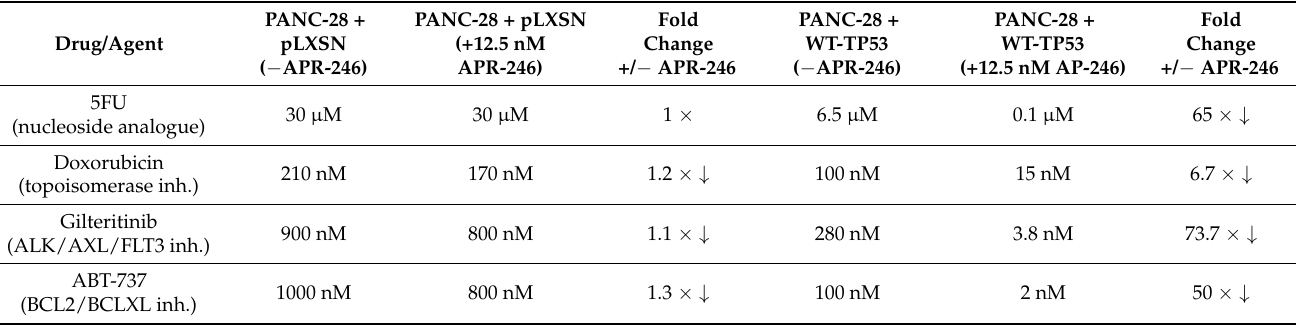
Table 2. Effects of WT-TP53 on the sensitivity of PANC-28 PDAC cells to APR-246 1